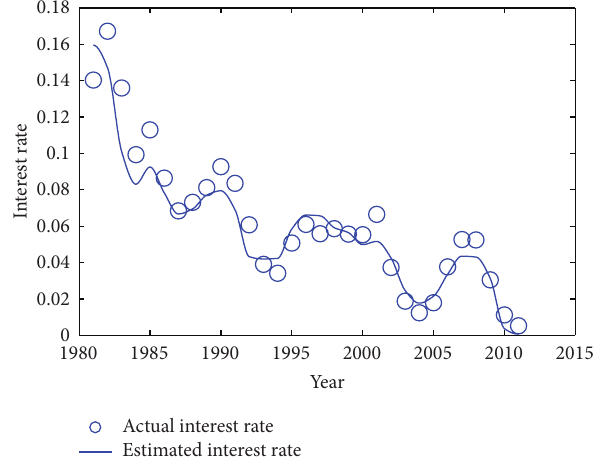
Figure 1: The actual interest rate versus estimated interest